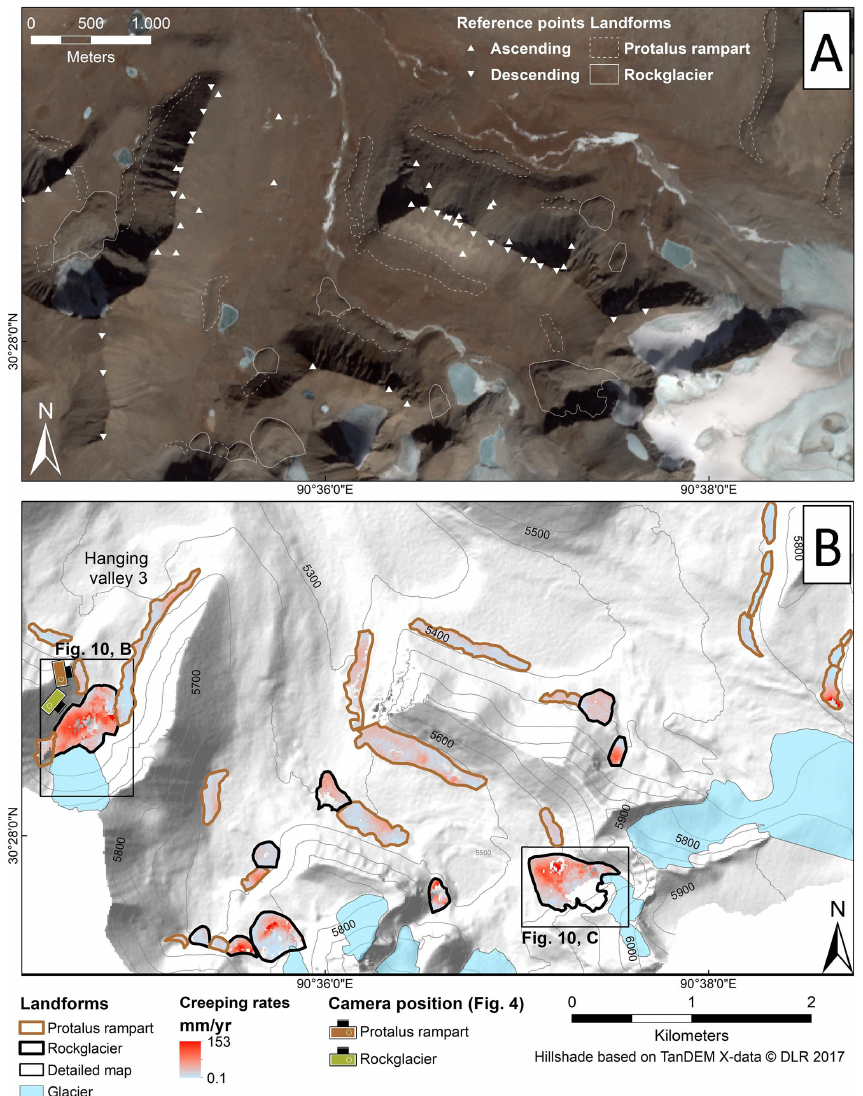
Figure 9. (a) Sentinel-2 satellite image, recorded 30 January 2018. Triangles indicate stable reference points. Dashed lines indicate the outlines of the periglacial landforms. (b) Creeping rates from periglacial landforms move in the slope direction over the observation period 2015–2018. The black rectangles mark the location of the two fastest rock glaciers in Fig. 10. The camera positions correspond to the photographs in Fig.